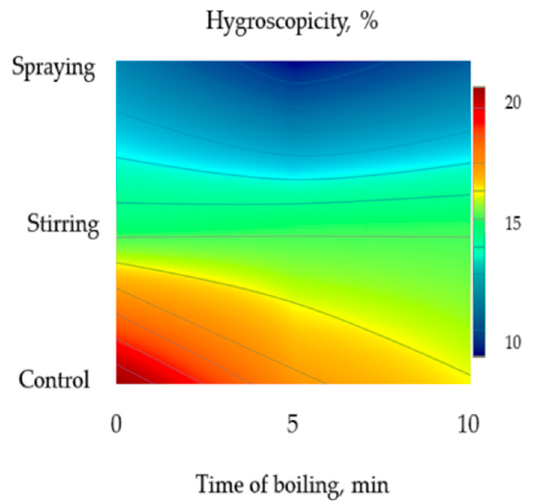
Figure 6. Two-dimensional fuzzy contour plotting for the interactive effect of time of boiling and method of addition on the hygroscopicity of non-wood pellets from pressing residual biomass from distillation of cellulosic bioethanol with liquid-state food waste.